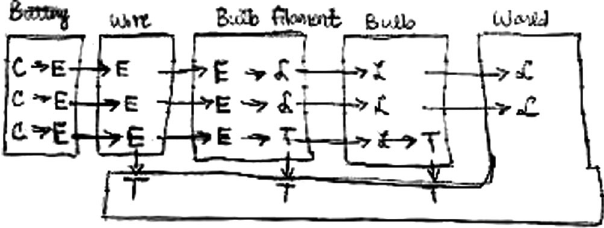
FIG. 10. A learner-invented “ energy branching ” diagram for a single-bulb circuit